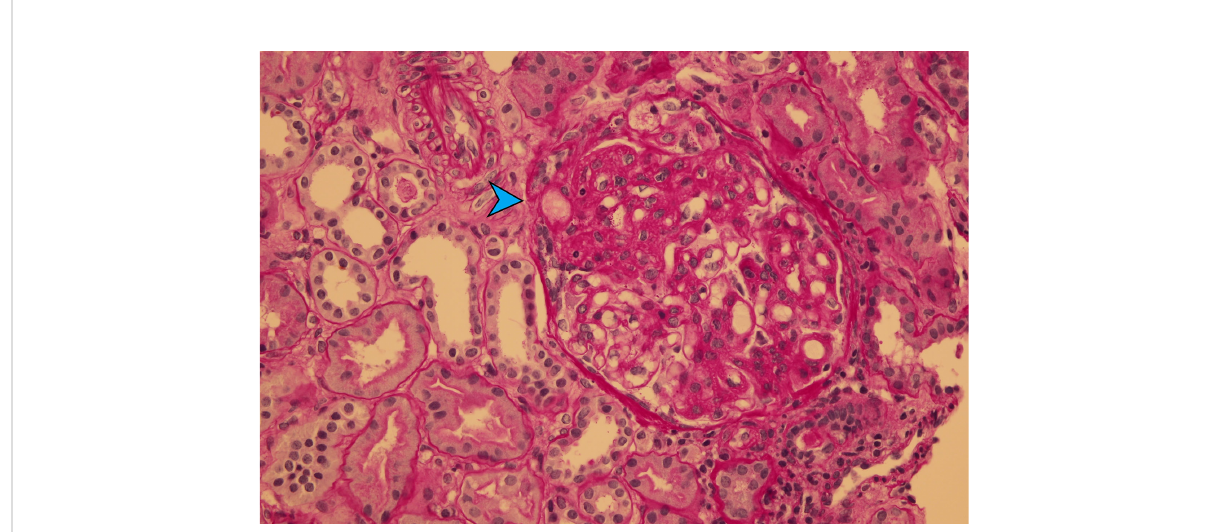
FIGURE 3 Chronic TMA represented by segmental glomerulosclerosis (blue arrow)